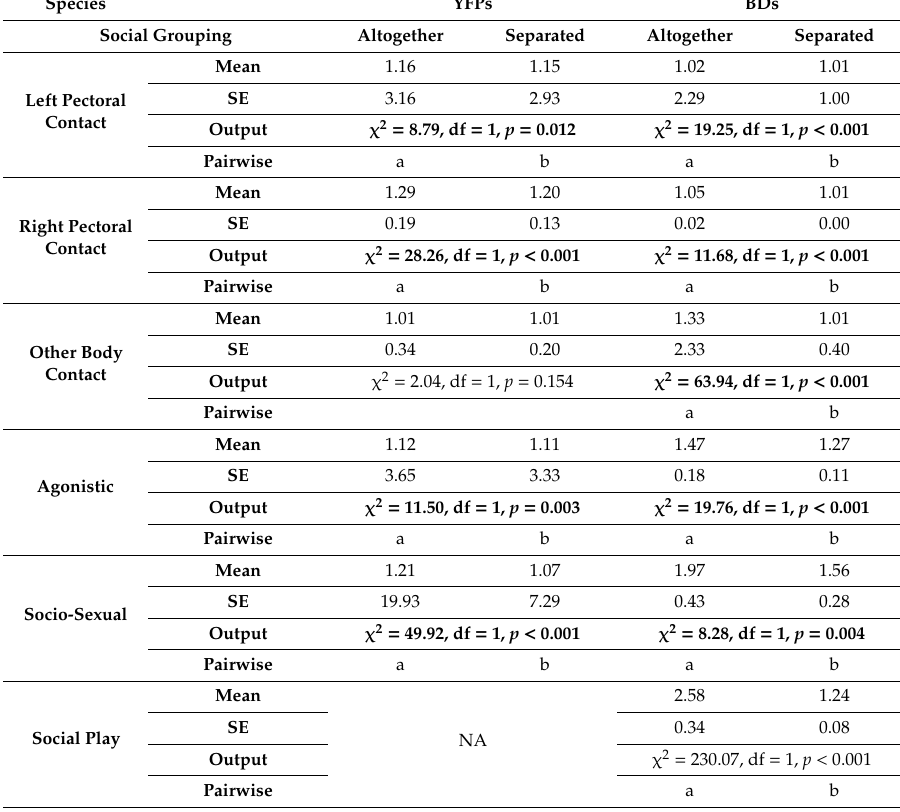
Table 5. Fitted means and standard errors of the frequency of each social behaviour, depending on social grouping for Yangtze finless porpoises (YFPs) and bottlenose dolphins (BDs). Outputs come from Wald chi-squared tests run on Generalized linear mixed models, significant outputs are bolded. For each species and each behaviour, items sharing the same letter did not di ff er significantly, items